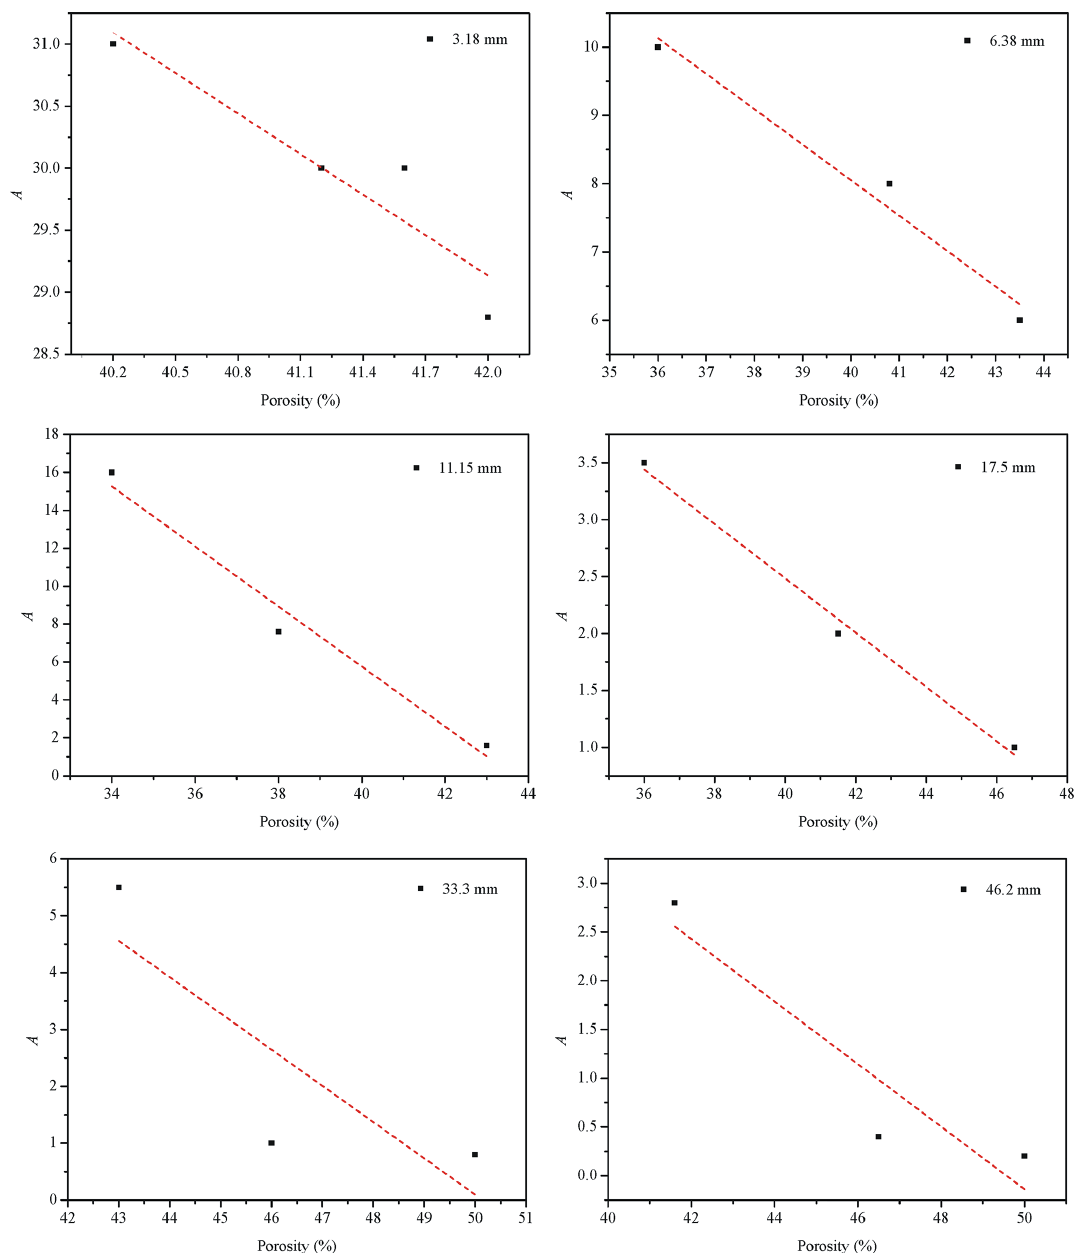
Figure 16. Variation of A with n for six gravels with different particle